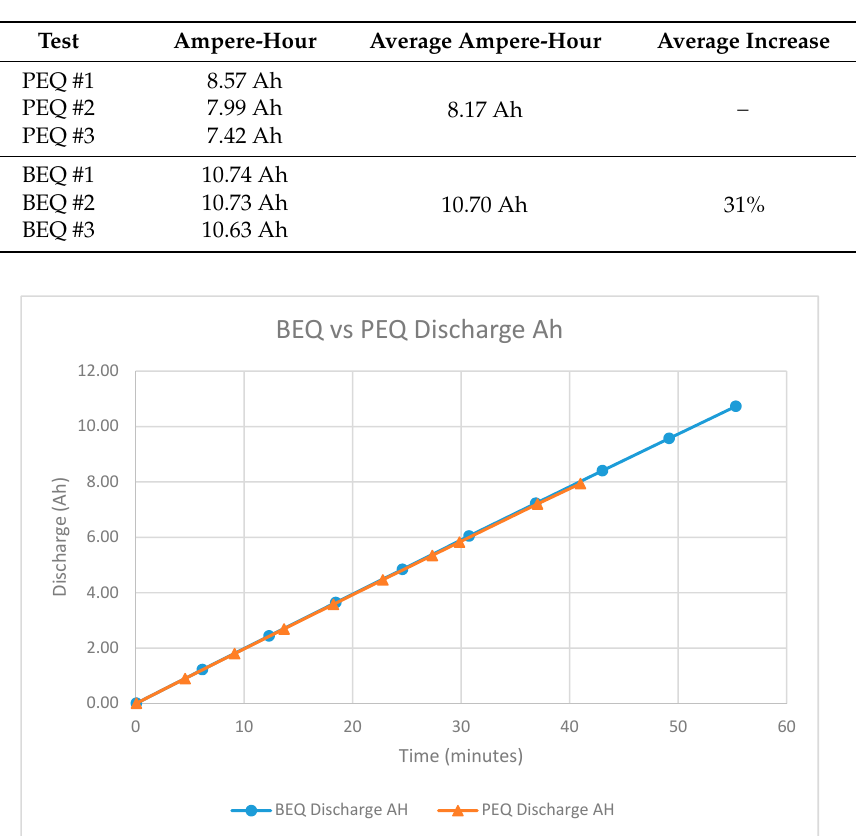
Table 2. Discharge data with 23 GAIA cells and 1 Boston Power cell.